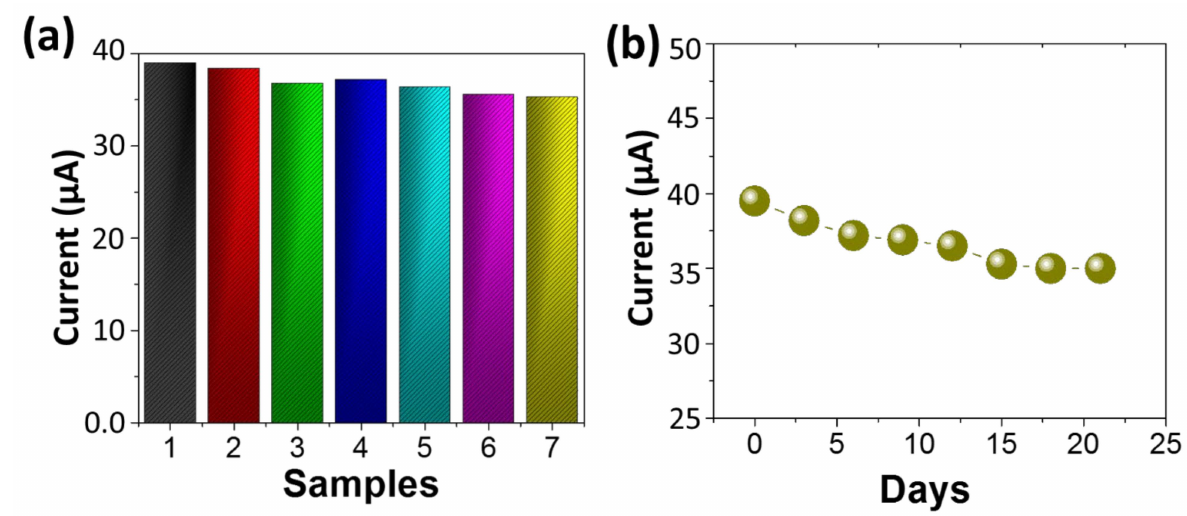
Figure 6. ( a ) Reproducibility of the fabricated 07 NEGS under identical condition, exposed with 0.1 mM glucose, ( b ) Stability of NEGS over period of 21 days. Table 2. Comparison of sensing performance of developed NEGS with earlier reported non-enzymatic sensors (Each experiment was performed in triplicate, and data shown below are the average of them). Concentrations (mM) Spiked Glucose Sample Detected by [mM] Developed NEGS